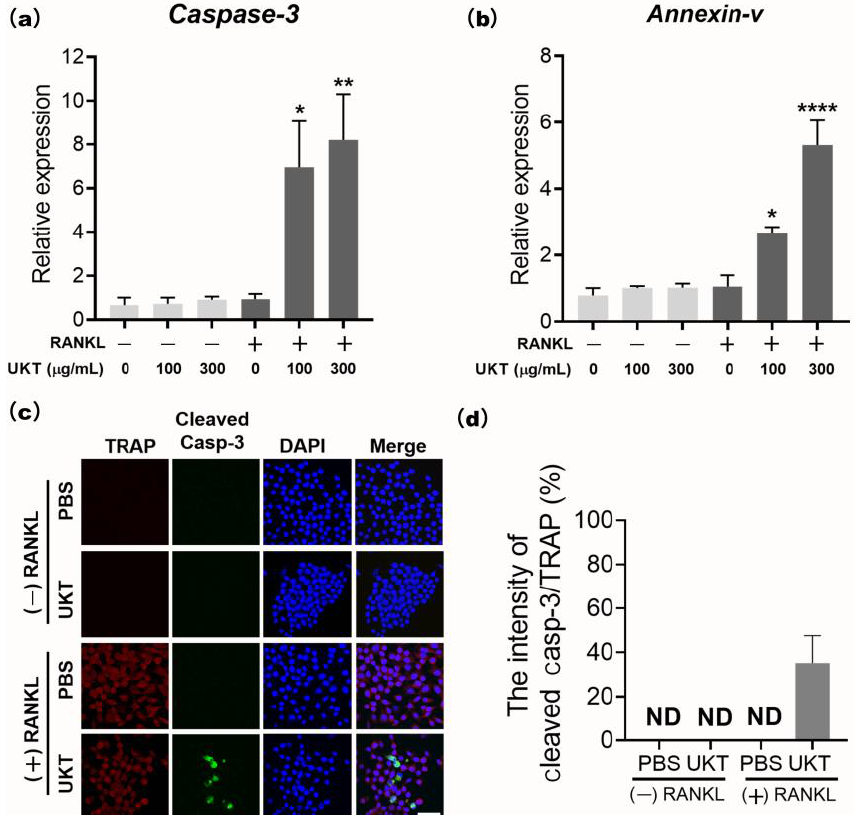
Figure 5. Unkeito (UKT) induces mononuclear osteoclast apoptosis via caspase-3 activation. ( a ) caspase-3 and ( b ) annexin-v mRNA expression in the early stage of apoptosis, normalized to that of Gapdh ; ( c ) cleaved caspase-3 abundance detected via immunocytochemistry ( n = 3; scale bar = 10 µm); ( d ) the percentages of cleaved caspase-3 positive in total of tartaric acid resistant phosphatase (TRAP) -positive cells. Error bars represent ± standard error of the mean. * p < 0.05; ** p < 0.01, **** p < 0.0001, versus negative control groups (PBS without RANKL); ND: not detected.